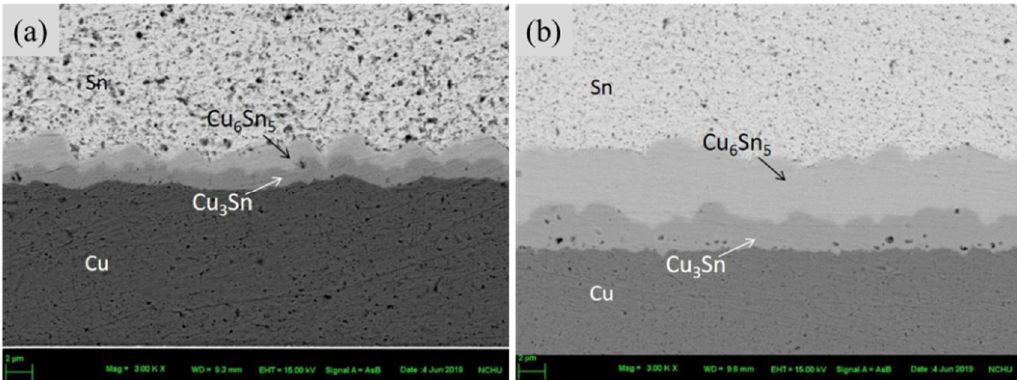
Figure 8. Intermetallic compound (IMC) formation after thermal annealing: ( a ) sample heated at 130 °C for 3 days; ( b ) sample heated at 180 °C for 4 days.